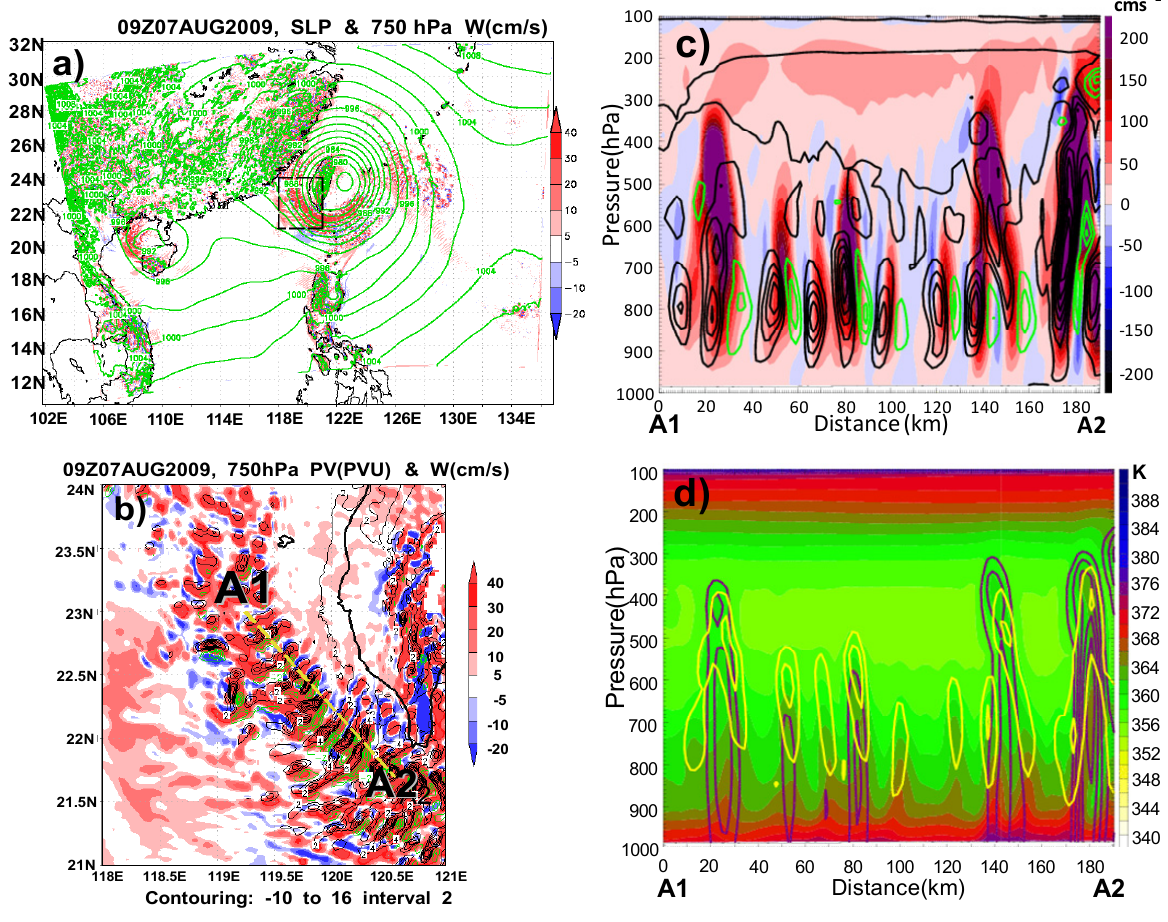
118E 118.5E 119E 119.5E 120E 120.5E 121E Contouring: -10 to 16 interval 2 Figure 8 Fig. 8. (a) Simulation of horizontal distribution of surface pressure (contour) and vertical velocity (shaded) at 750hPa at 09:00UTC 7 August 2009. (b) Same as Fig. 7 but for 09:00UTC 7 August (c) The cross-section distribution along A1–A2 in (b) for vertical velocity (shaded) and potential vorticity (Positive in black and negative in green, interval 2 PVU) (d) Same as (c) but for equivalent potential temperature (shaded), Total precipitation mixing ratio (contour in purple) and total cloud mixing ratio (contour in yellow).